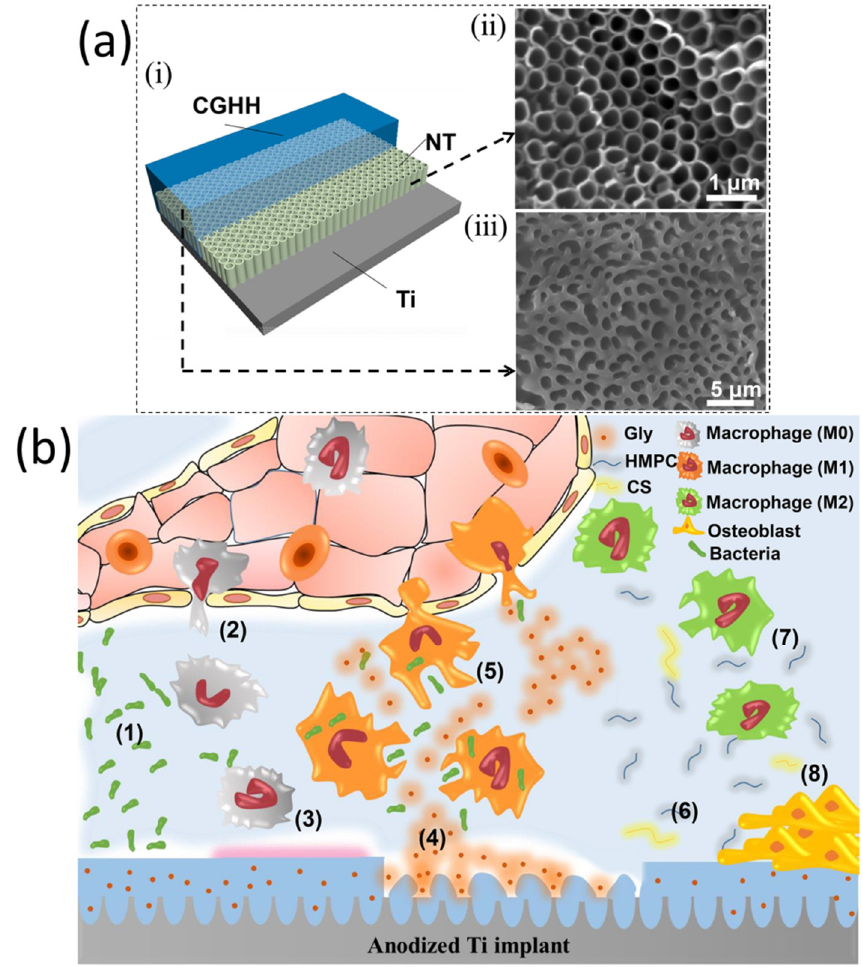
Figure 3. ( a ( i )) schematic illustration of the CGHH@NT sample; ( a ( ii )) SEM image of the NT sample; ( a ( iii )) SEM image of the CGHH@NT sample, ( b ) schematic illustration of the thermo-sensitive immunoregulation of the CGHH@NT sample: (1) bacterial infection; (2) macrophages recruitment; (3) local temperature increase; (4) phase transformation of CGHH@NT from sol state to gel state, their roles in bacteria killing, (6) local temperature decrease resulting in the phase of CGHH@NT